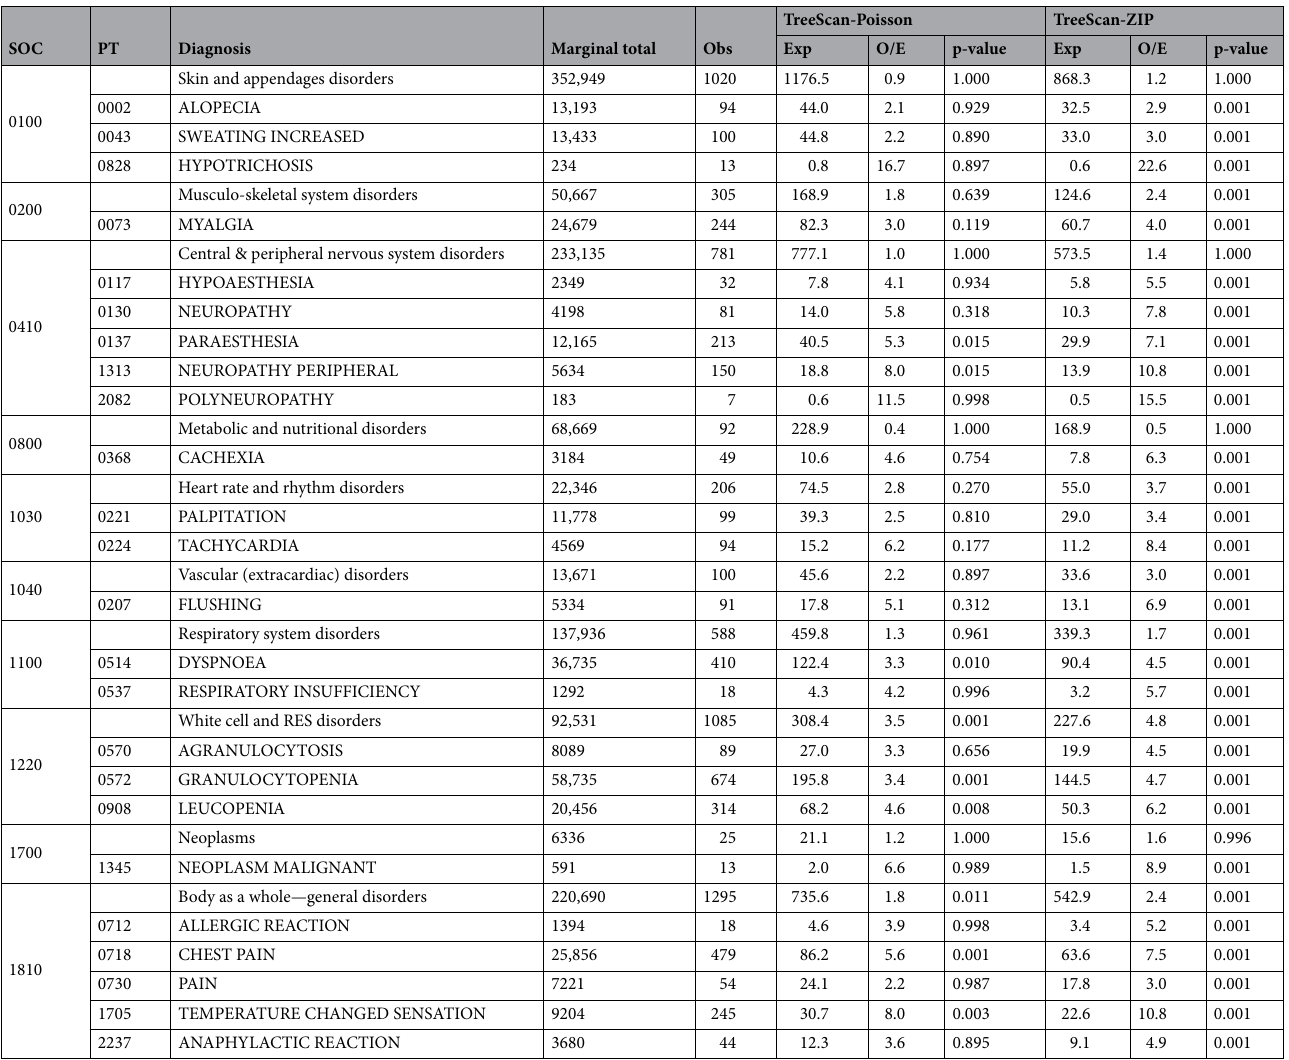
Table 3. Results of signal detection of adverse events of paclitaxel by the two